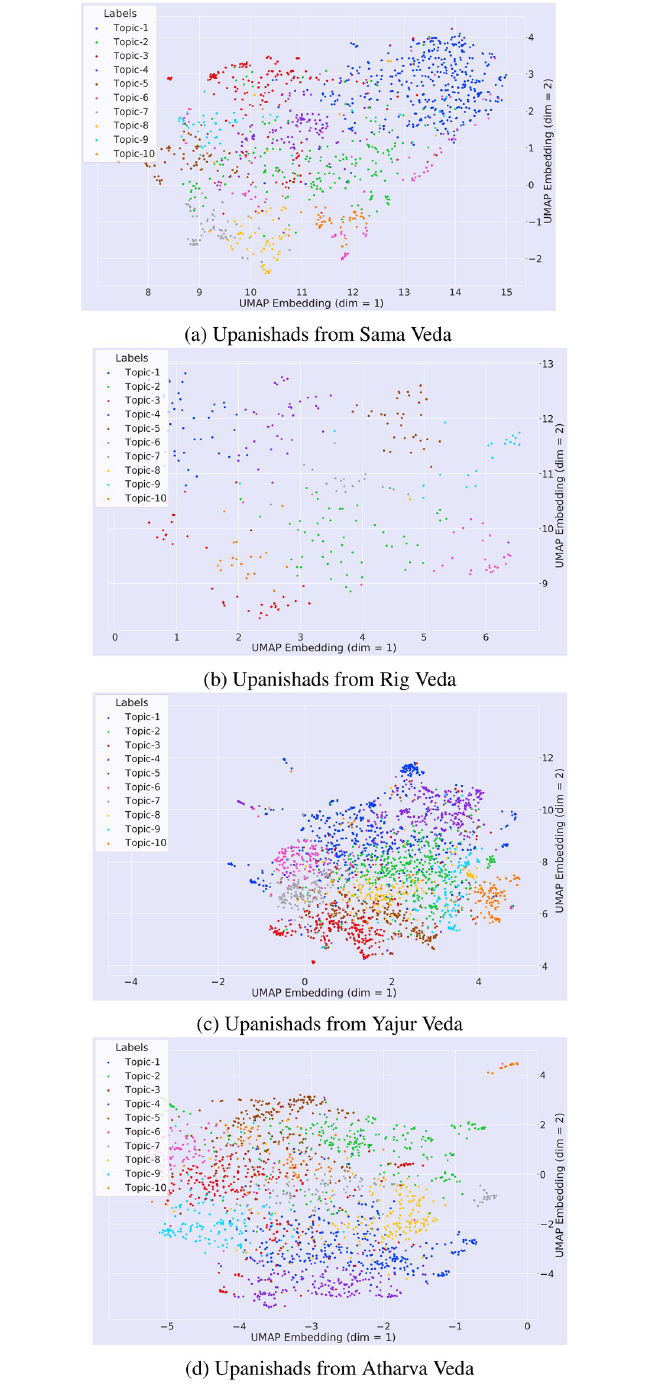
Fig 10. Visualization of the semantic space of different parts (based on 4 Vedas) of 108 Upanishads.